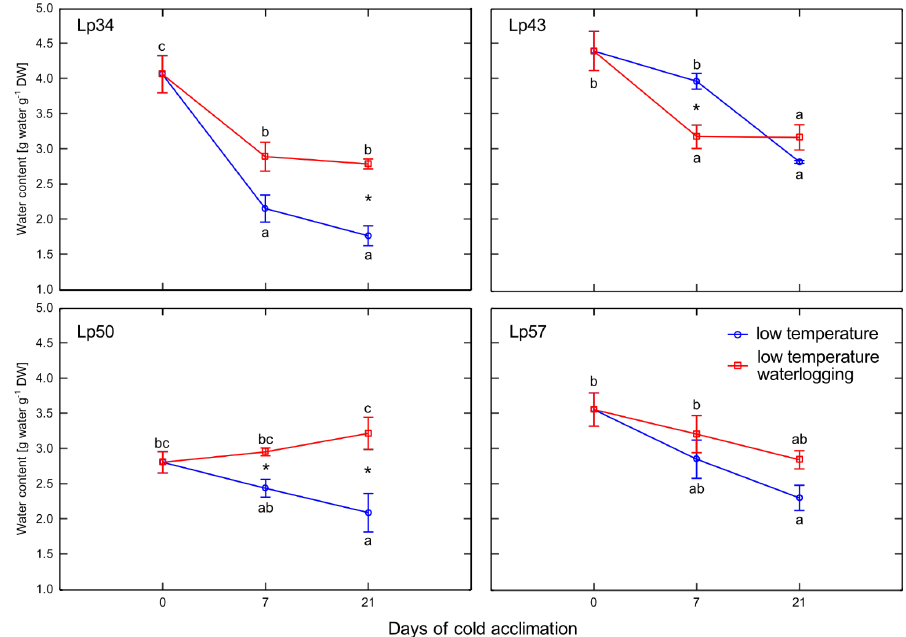
Figure 4. Water content of cold-acclimated Lolium perenne genotypes. Four genotypes (Lp34, Lp43, Lp50, and Lp57) were tested. The results are means ( n = 4), error bars indicate the standard error. Asterisks indicate means that differ significantly between waterlogged and control plants according to one-way ANOVA ( p < 0.05). Different lower-case letters indicate means that are statistically different according to Duncan’s multiple range test ( p < 0.05). Int. J. Mol. Sci. 2021 , 22 , x FOR PEER REVIEW 2.5. ABA Content Increase in ABA content was observed in waterlogged Lp43 plants relative to that of the control after 7 days of cold acclimation (Figure 5). This change was a consequence of a transient increase (between 0 and 7 days of the experiment) in ABA content of waterlogged plants. This ABA increase coincided with the decrease in water content detected in waterlogged Lp43 plants. In the other three genotypes, no changes in ABA content were observed in response to waterlogging.